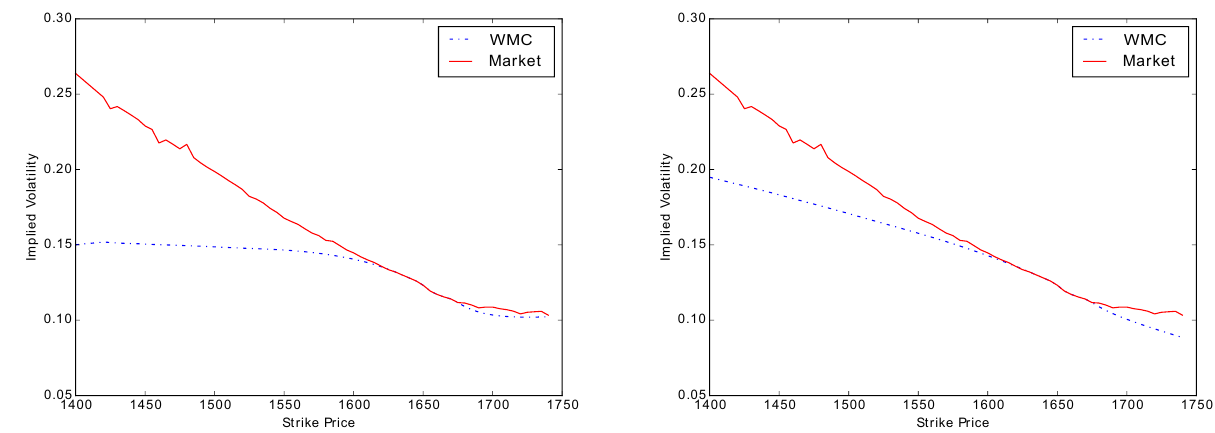
Figure 1. Typical view of the volatility for SPX options implied by market prices and by the WMC calibrated GBM model ( left ) or Heston model ( right